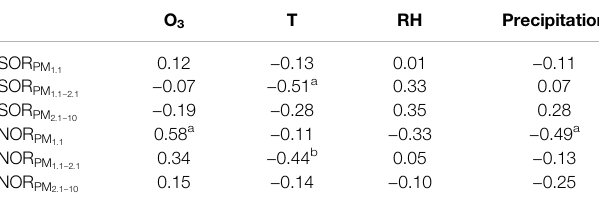
TABLE 4 | Correlation coef fi cient of NOR and SOR between O 3 concentrations, Temperature, Relative humidity and Precipitation in particulate